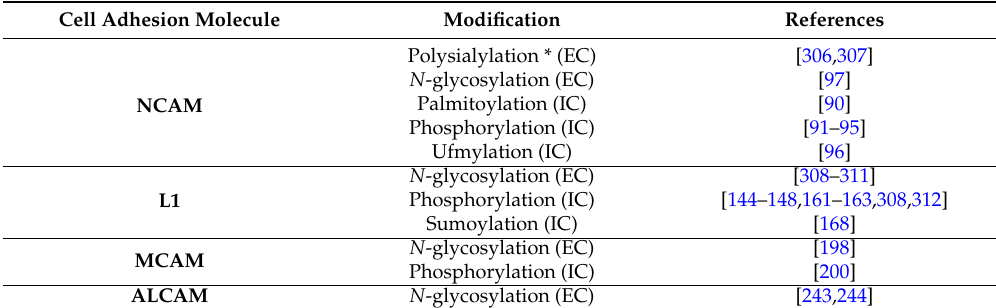
Table 1. Overview about the above mentioned posttranslational modifications of the described cell adhesion molecules. EC, extracellular; IC, intracellular; * form of N -glycosylation.